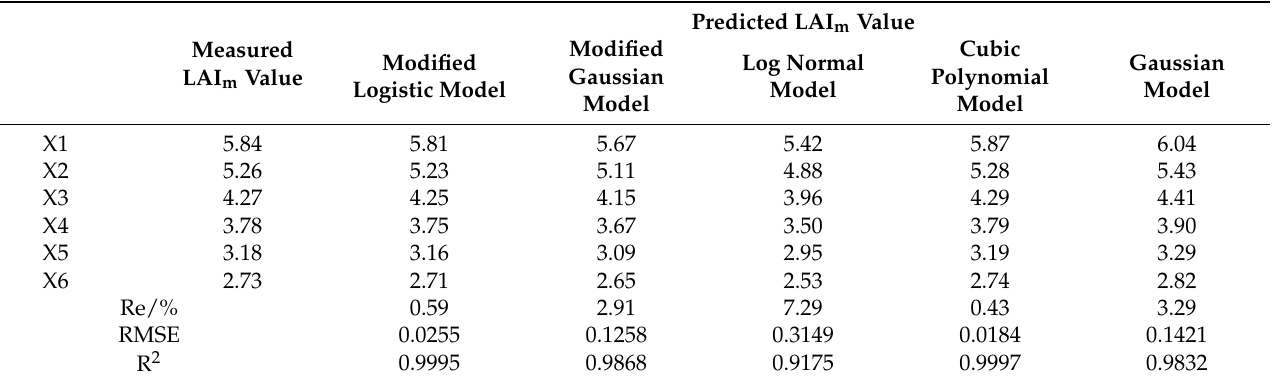
Table 4. Predicted maximum leaf area index (LAI m ) values and associated statistical parameters for the different models considered in this work. Re is the relative error, R 2 is the coefficient of determination, and RMSE is the root-mean-square error.